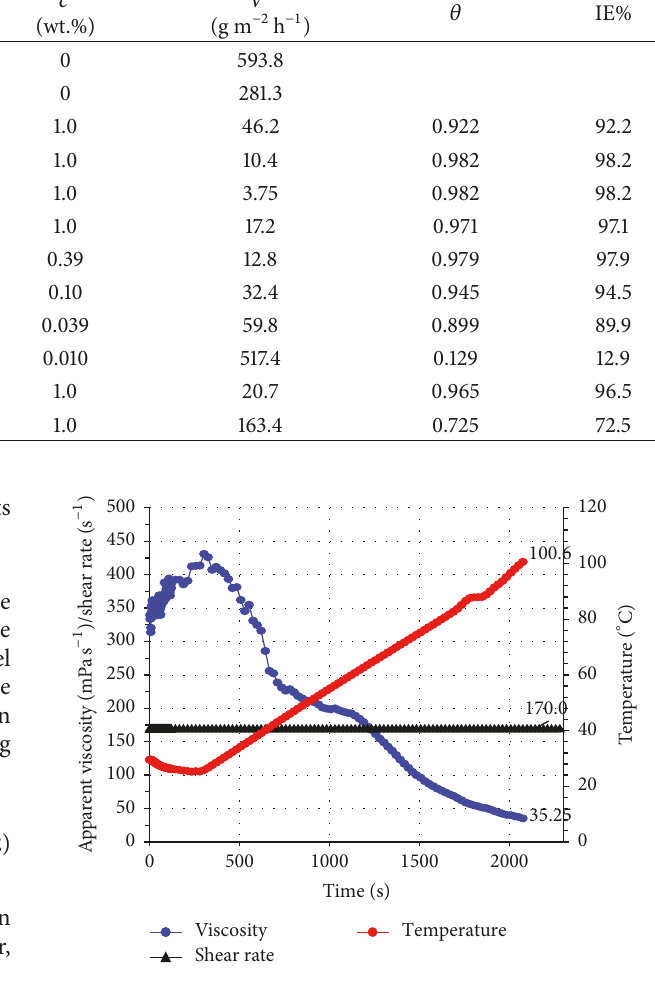
Figure 6: The apparent viscosity of 4wt.% of surfactant 2d with 0.36% NaSal under steady shear rates 170 s −1